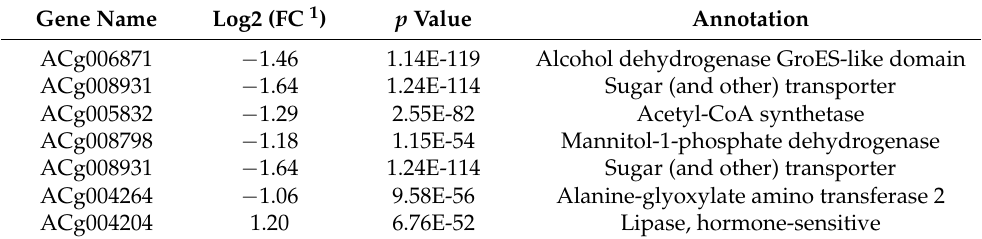
Table 1. DEGs relevant to glycolysis/gluconeogenesis, propanoate metabolism and fatty acids